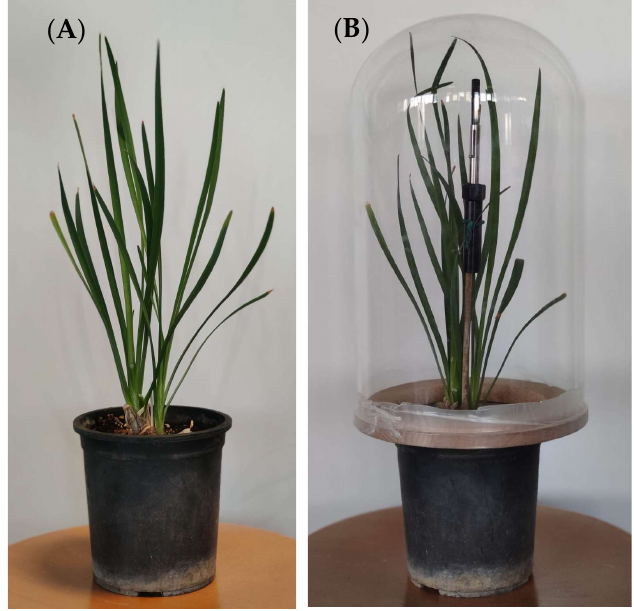
Figure 3. T. violacea plant in a pot ( A ) and under a glass bell in the presence of SPME fiber ( B ).